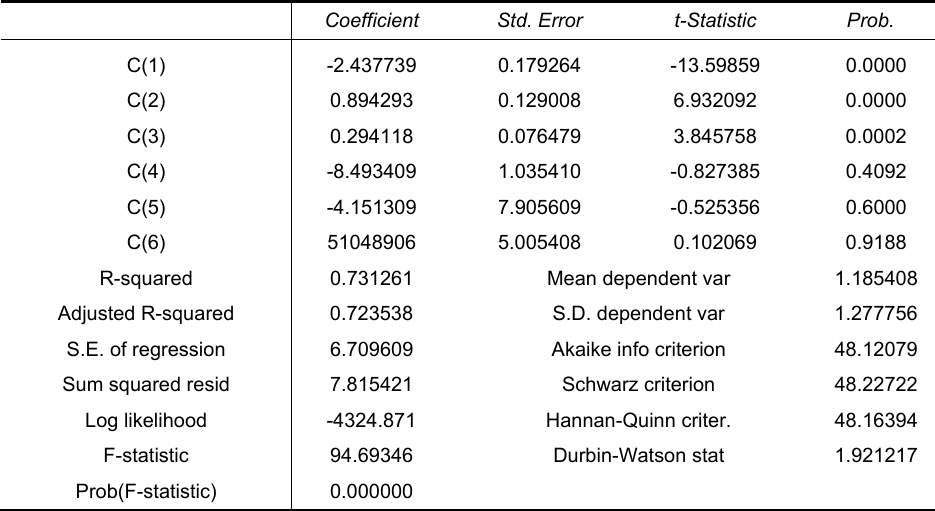
Table 8: Long run causality model